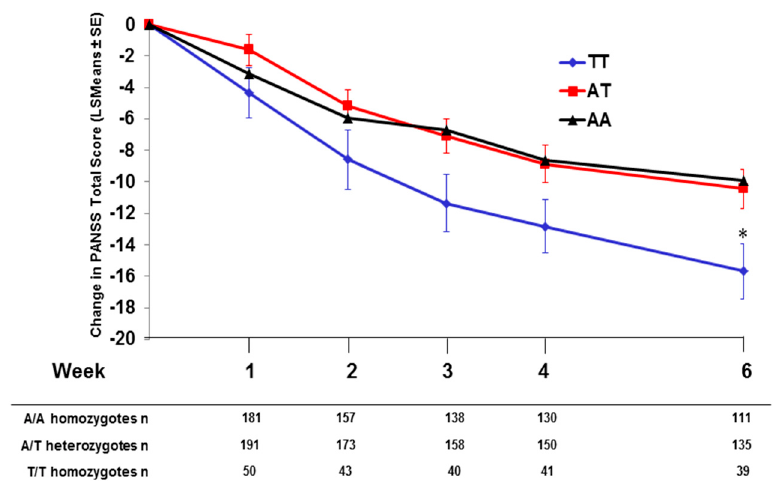
Figure 6. Integrated analysis; change in PANSS total score by HTR2A SNP rs7330461 genotype in Caucasian patients treated with pomaglumetad methionil 40 mg BID; data from Studies 2, 3, 4 and 5. Abbreviations: BID = twice daily; HTR2A = serotonin 2A receptor ( HTR2A ) gene; LSMean = least squares mean; n = number of patients with PANSS measures; PANSS = Positive and Negative Syndrome Scale; SE = standard error; SNP = single nucleotide polymorphism. Type I error rate < 0.05 for T/T being the most responsive genotype based on Hsu’s multiple comparisons with the best (MCB) method in the PANSS total analysis. * Two-sided p = 0.0073 for T/T versus A/A and two-sided p = 0.0098 for T/T versus A/T. 2.5. Pomaglumetad Methionil versus Placebo in the Integrated Analysis